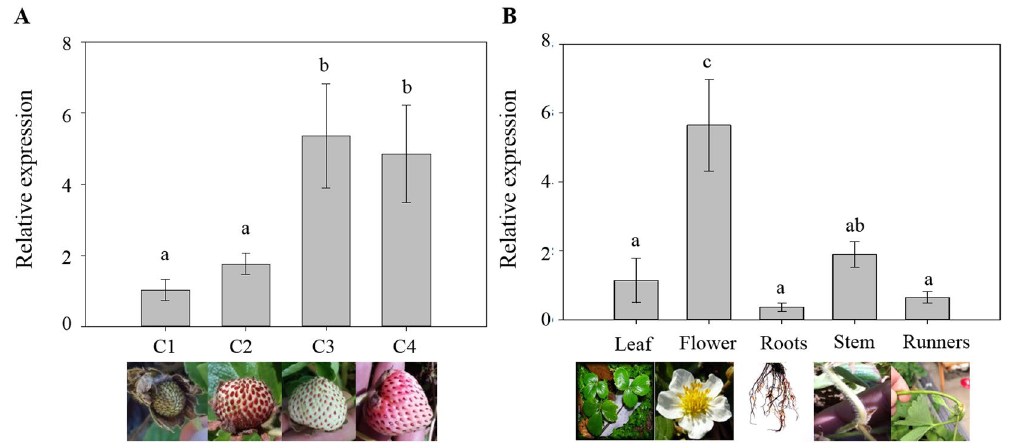
Figure 4. Levels of FcNAC1 transcripts in different F . chiloensis tissues. Quantification of transcripts was performed by qRT-PCR employing specific primers: ( A ) during development and ripening of Fragaria chiloensis fruit (C1, C2, C3 and C4); ( B ) different plant tissues (leaves, flowers, roots, stem and runners). RNA extractions from the samples were performed using the CTAB method. FcGAPDH was used as internal calibrator gene. Different letters indicate statistical difference between fruit stages ( A ) or plant tissues ( B ). Significant differences were determined at p ≤ 0.05 (LSD Fisher test). In order to facilitate the comparison of transcripts level, C1 fruit stage in A, and leaf in B were normalized to 1. All pictures were taken by one of the